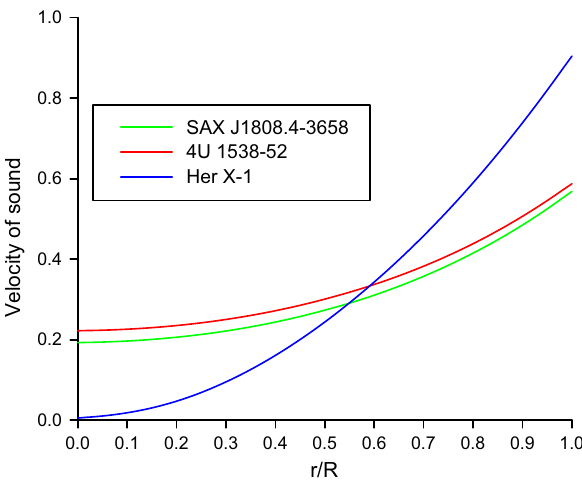
Fig. 3 We have plotted the velocity of sound against r / R for the com- pactstarcandidatesSAXJ1808.4-3658,4U1538-52andHerX-1inside the stellar interior by employing the same values of the constants